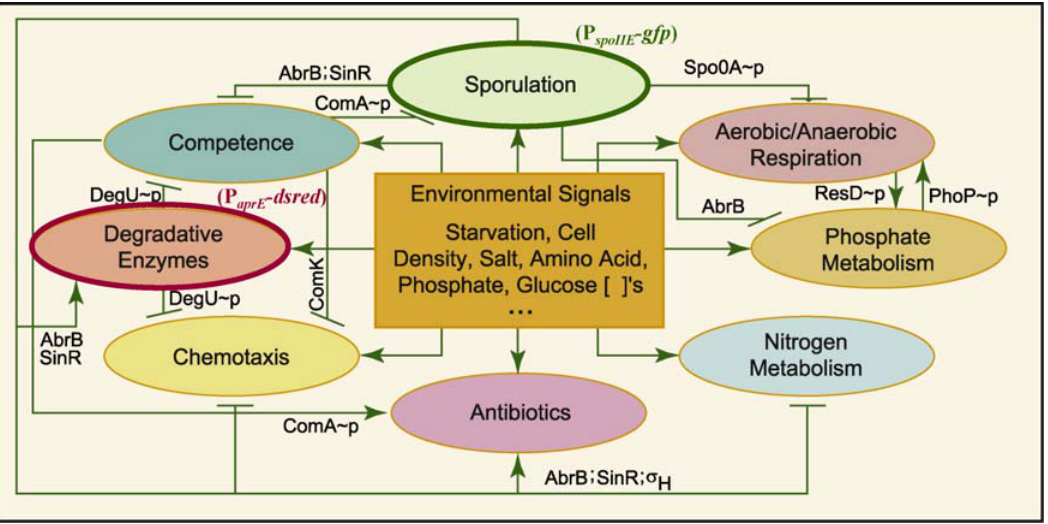
Figure 1. The B.subtilis stress response meta-network, where each oval represents both a stress response and the regulatory network of 100 or so interacting molecular species that regulates it. Among the many ingenious genetic and biochemical programs employed by B. subtilis to cope with environmentally adverse conditions are its ability to take up extracellular DNA, competence [40,76]; differentiate into an inert heat-, chemical, and UV-resistant spore [37]; secrete degradative enzymes to identify and digest new food sources [77]; become motile and chemotax toward possibly better surroundings [78]; synthesize antibiotics to eliminate competitors in the same ecosystem [79,80]; turn on alternative metabolic pathways, and form biofilms ([81], not shown), just to name a few [38]. The cross-repressive feedback between sporulation and competence, and the many positive feedback loops within each large ‘individual’ stress response pathway [10,36–40,82], are suggestive of switches and other elements that could potentially encode memory. The two stress response pathways monitored in our experiments, sporulation and synthesis of the degradative enzyme subtilisin, are denoted by bold-faced ovals. The fluorescent reporters (GFP and DsRed) fused to the respective promoters P spoIIE and P aprE are indicated (see Materials and